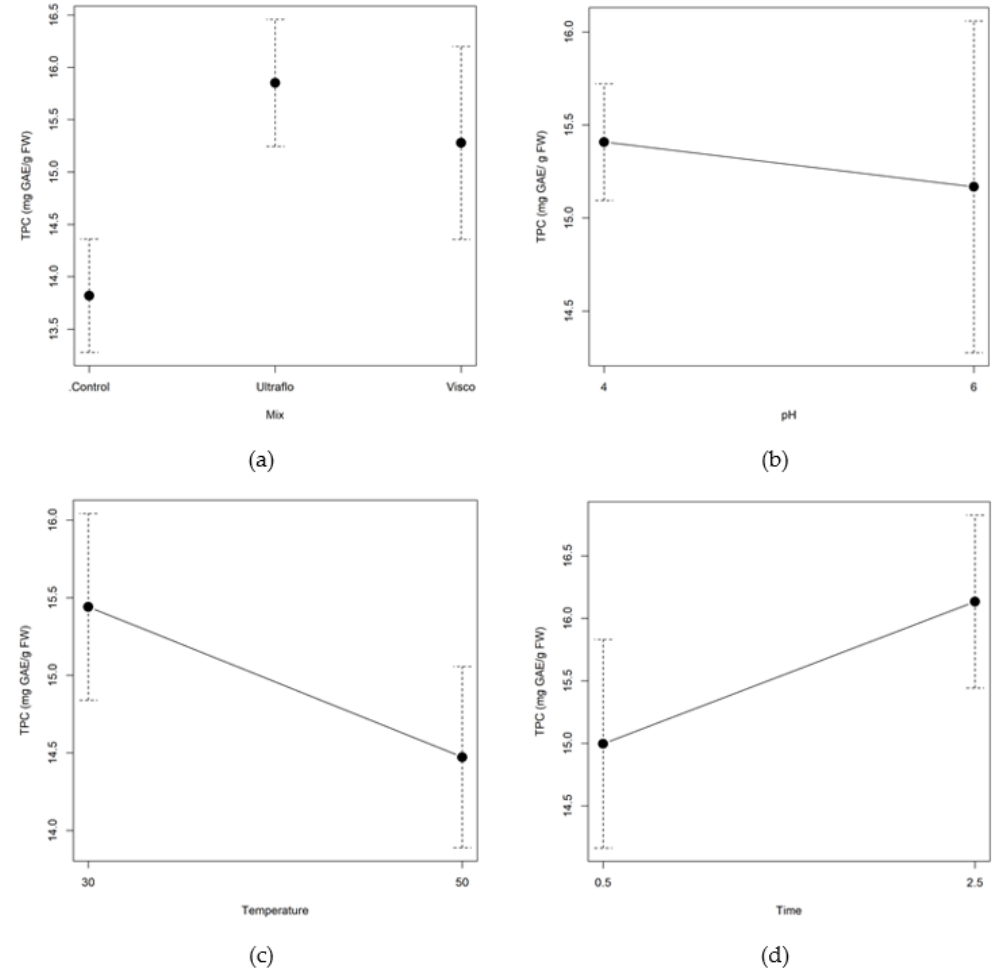
Figure A4. The total phenolic content (TPC; mg GAE/g FW) in ethanolic extracts plotted as a function of the ( a ) enzymatic mix (Ultraflo© and Viscozyme© ), ( b ) pH (4 – 6), ( c ) temperature (30 – 50 °C) and ( d ) time (0.5 – 2.5 h).